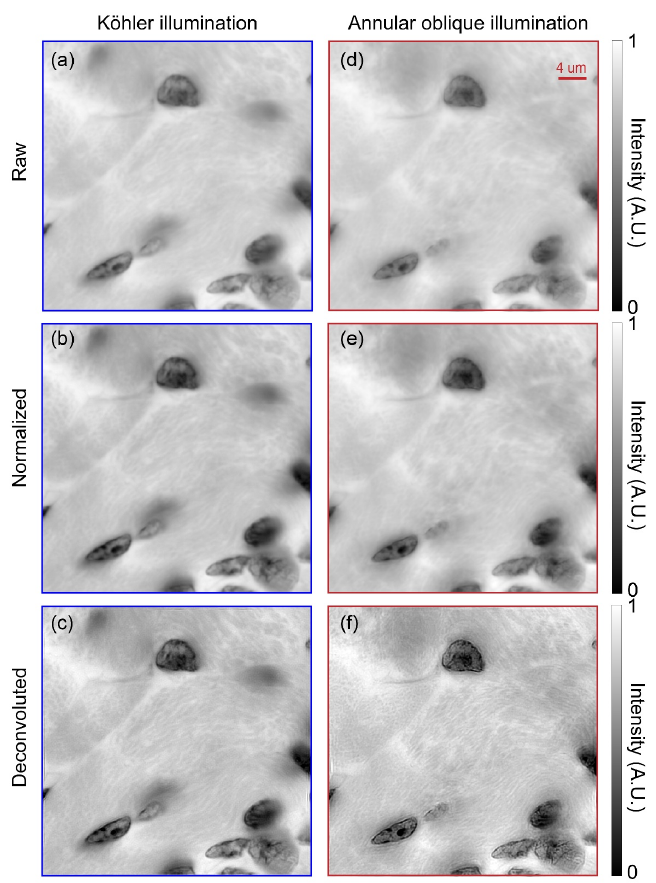
Figure 11. Images of a skeletal-muscle cross-section slide: ( a ) is a raw Köhler-illuminated image, ( b ) is the normalized image of ( a ), ( c ) is the deconvoluted image of ( b ); ( d ) is a raw annular oblique- illuminated image, ( e ) is the normalized image of ( d ), ( f ) is the deconvoluted image of ( e ). Compared to the resolution target, the biological sample had a complicated structure.